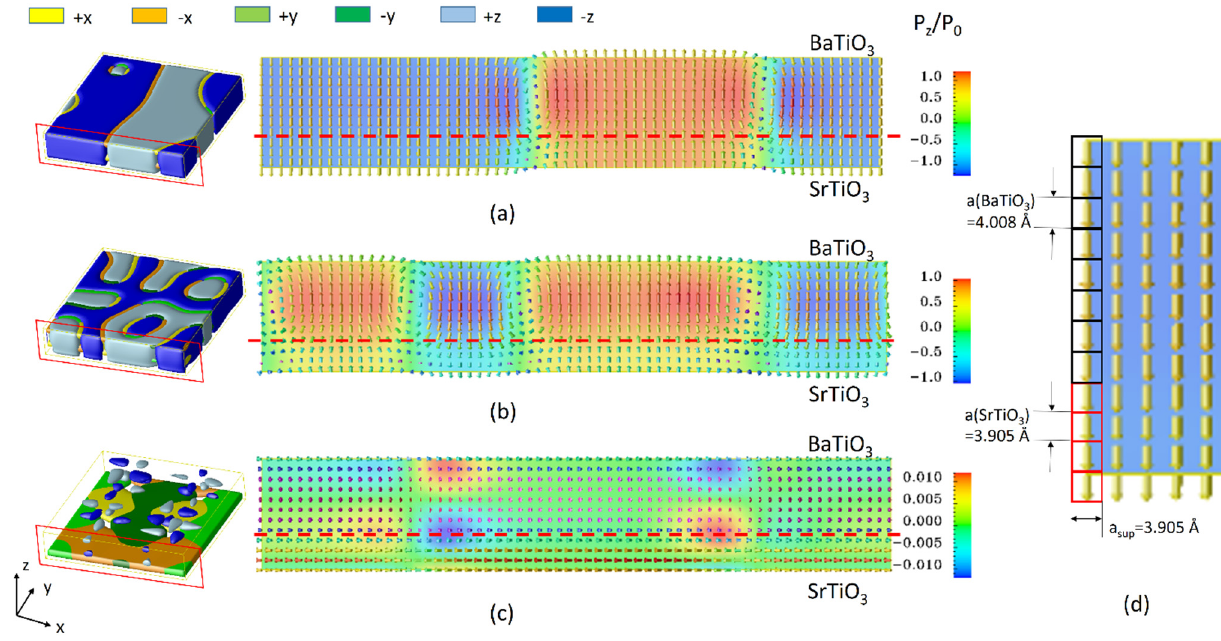
Figure 2. The simulated superlattice ferroelectric domain structures (left) and the vector plot of polarization in the cross- section plane (right): ( a ) under the fully commensurate condition, ( b ) under a partially relaxed condition, and ( c ) under the fully relaxed condition. ( d ) A detailed vector plot of ( a ) with lattice grids. Please note the grid spacing ∆ x 1 = ∆ x 2 = a sup , ∆ x ∆ x 3 = 3.905 Å forthe SrTiO 3 layer, and 3 = 4.008 Å for the BaTiO 3